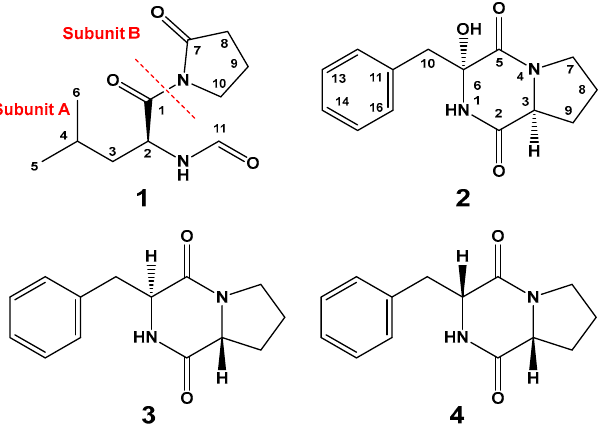
Figure 1. Chemical structures of compounds 1 – 4 .